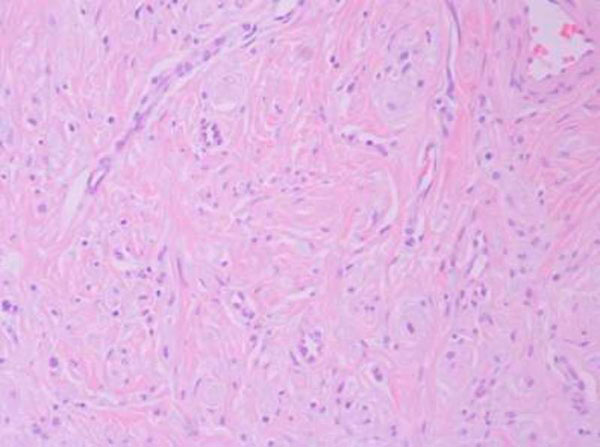
Histological section stained with hematoxylin & eosin (X 20).